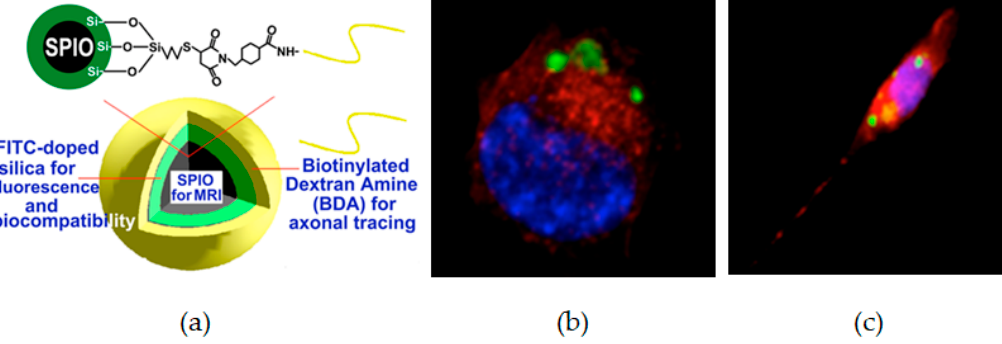
Figure 2. Trifunctional nanomaterial SPIO@SiO2(FITC)-BDA and its application as an axonal tracer. ( a ) Schematic representation of the axon tracer design showing a superparamagnetic iron oxide (SPIO) core, a middle layer of Fluorescein isothiocyanate (FITC)-doped silica, and the external layer of biotinylated dextran amine (BDA). Fluorescent confocal micrographs of ( b ) undi ff erentiated and ( c ) di ff erentiated N2a cells that have taken up SPIO@SiO 2 (FITC)-BDA nanoparticles. Reprinted with permission from Reference [25].